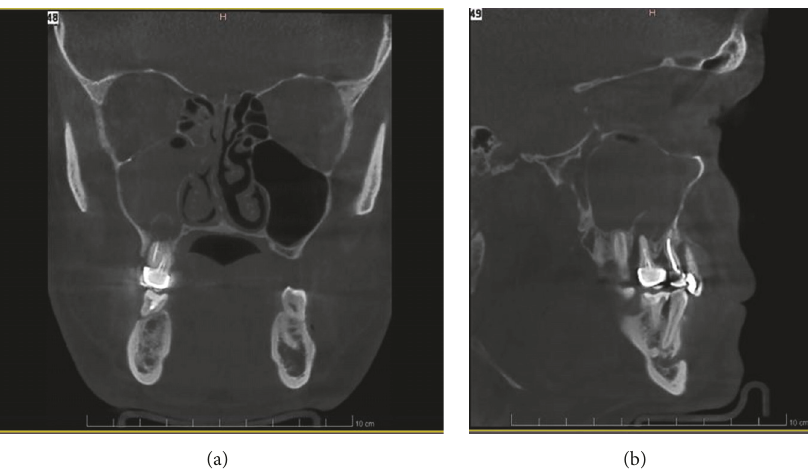
Figure 1: Coronal (a) and sagittal (b) CBCT-scan: well-defined hypodense lesion involving a distal and apical region (endo-perio lesion) of the endodontically treated right maxillary first molar. Maxillary and ethmoidal sinusitis and a perforation of the lesion into the right maxillary sinus cavity are also observed.